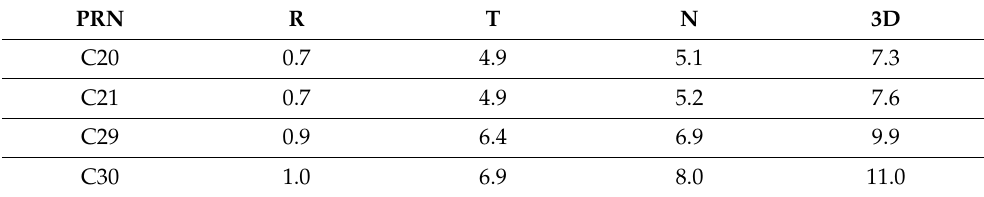
Figure 11. BDS-3 satellites simulated POD accuracy (with systematic errors). Table 7. The impact of 1 cm random error on simulated POD accuracy (unit: cm).